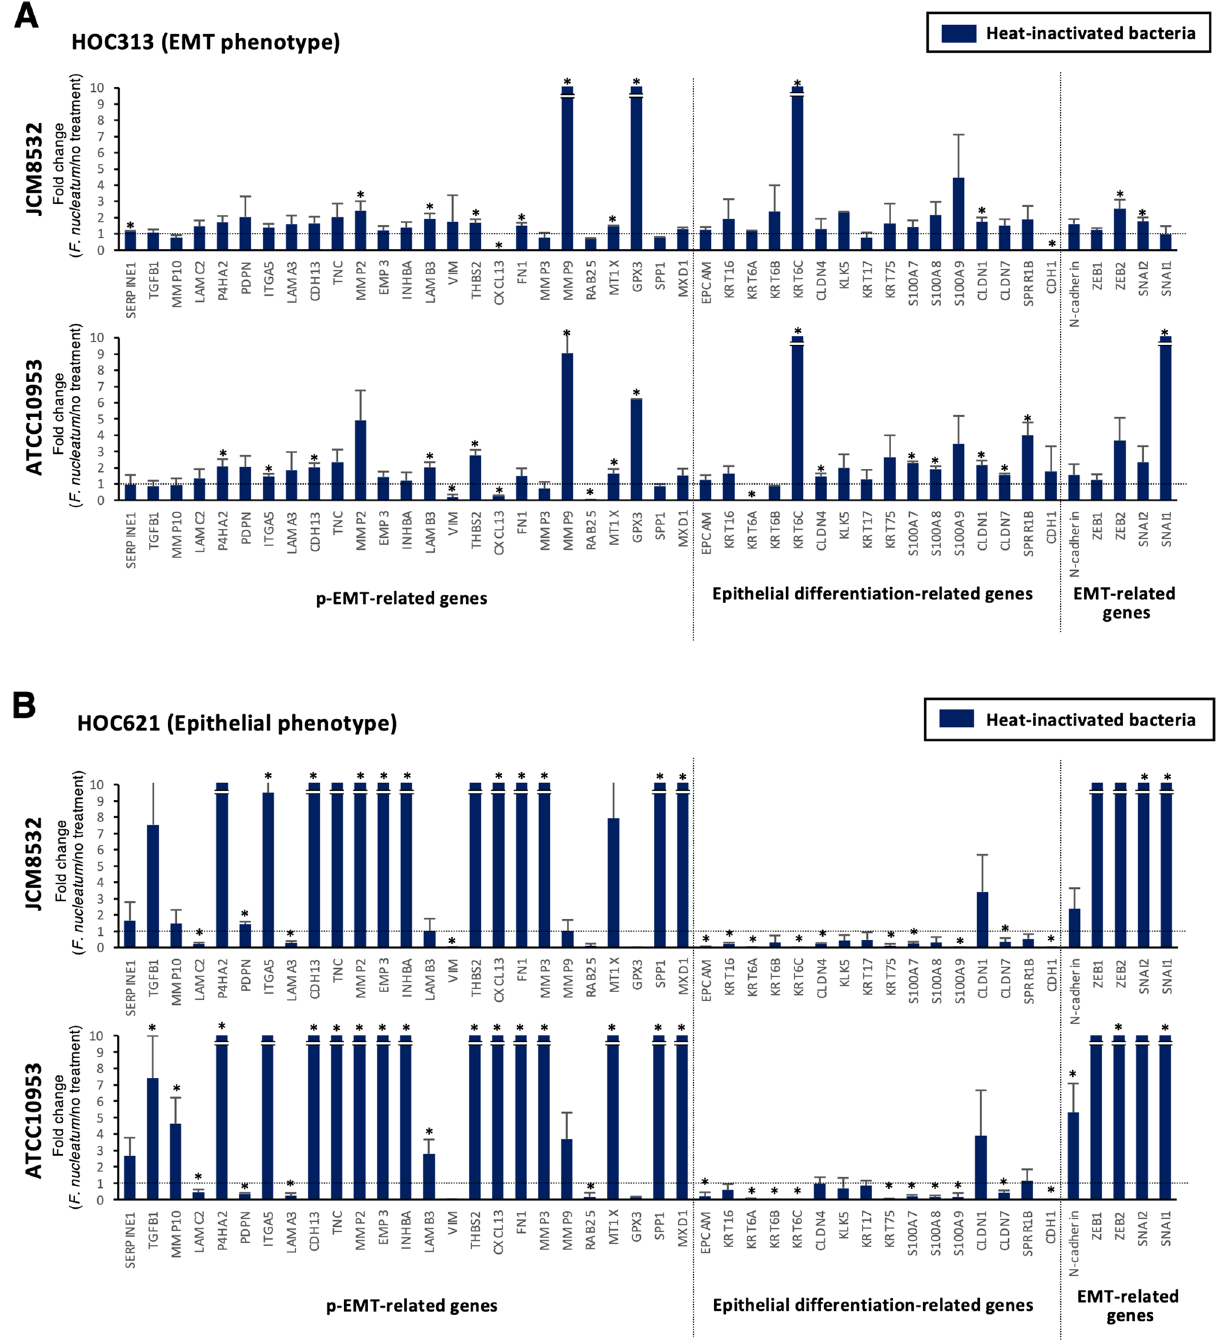
Figure 5. Co-culture with heat-inactivated F. nucleatum upregulates p-EMT-related genes in eEpithelial phenotype, HOC621 cells. After co-culture with heat-inactivated F. nucleatum (JCM8532 and ATCC10953, MOI = 10), expression of epithelial differentiation-related, p-EMT-related, and EMT-related genes was determined by qPCR in HOC313 ( A ) and HOC621 cells ( B ). The graphs show the results as mean ± S.D. of three independent experiments. (*) represents P -value of < 0.05 compared to control (no